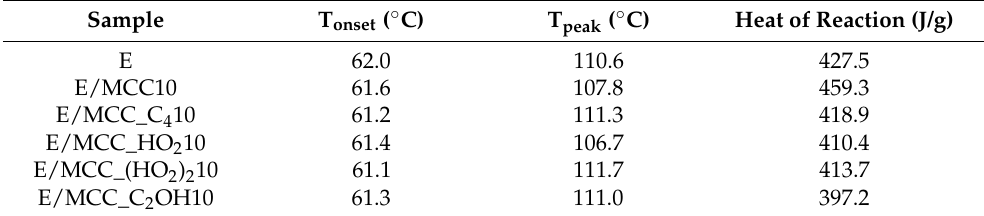
Table 2. DSC-derived curing data for epoxy and the MCC/epoxy composites.